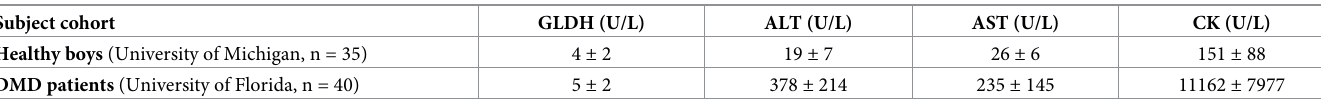
Table 1. GLDH levels are not affected by